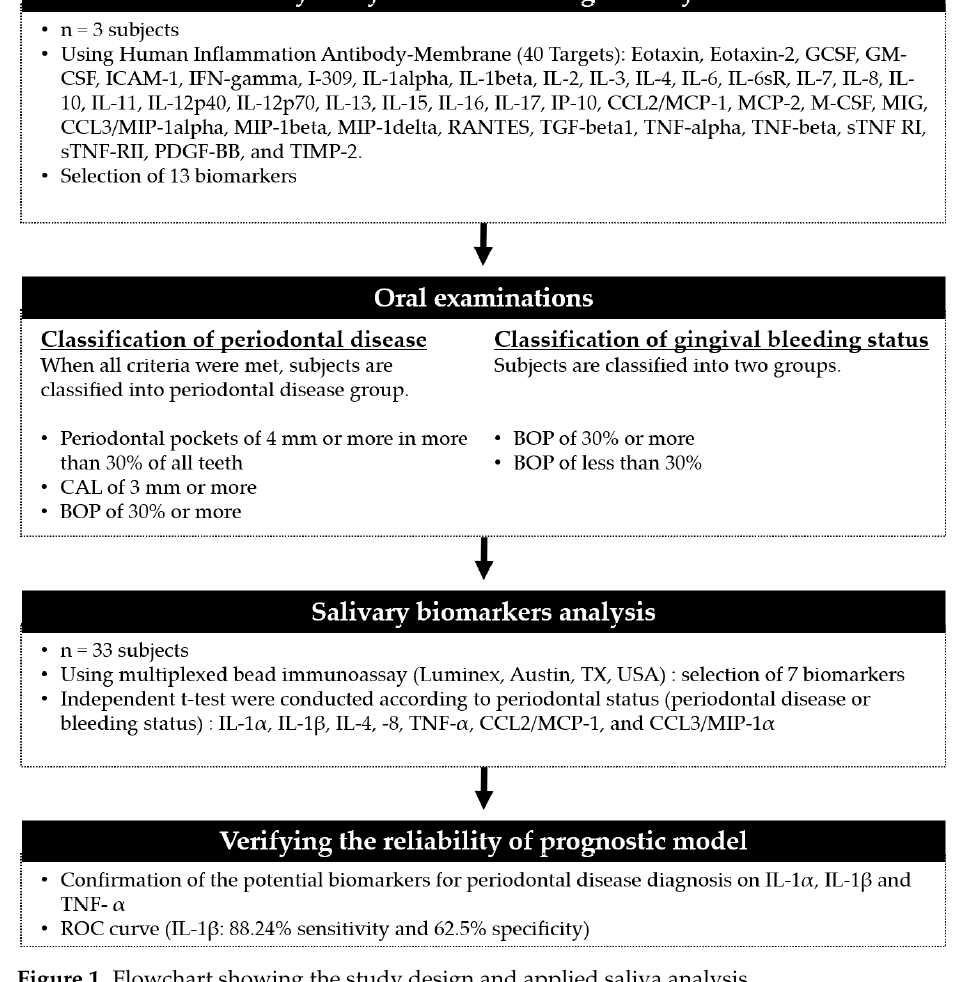
Figure 1. Flowchart showing the study design and applied saliva analysis.